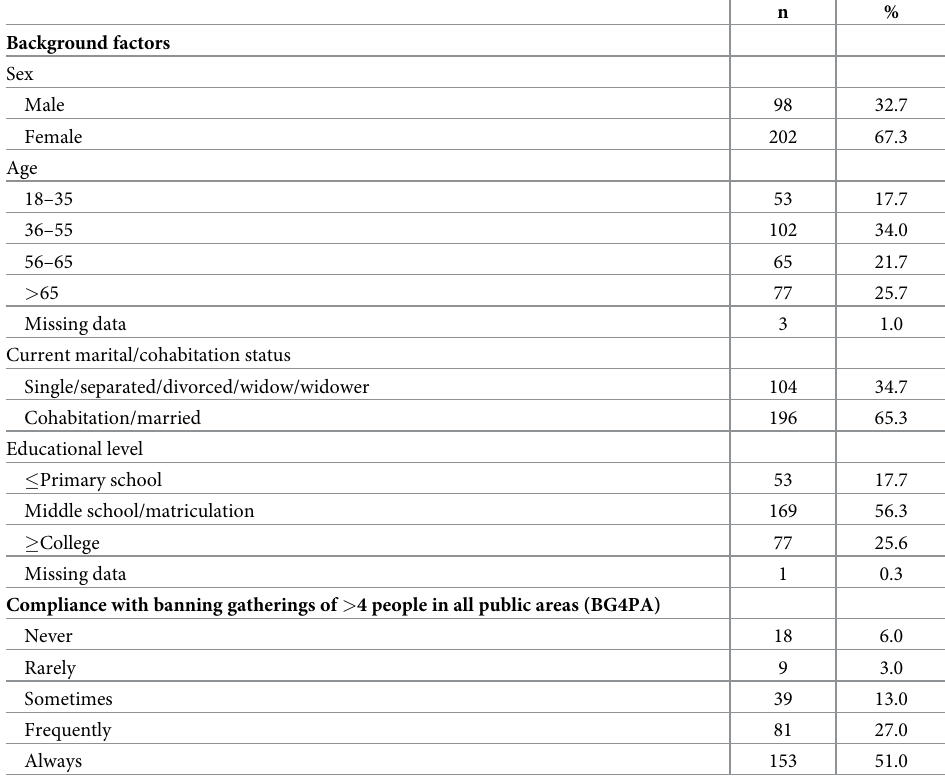
Table 1. Descriptive statistics of the participants (n =